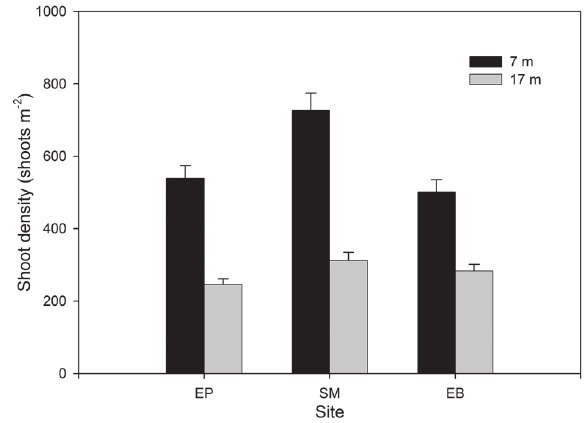
Fig . 1. – shoot density (shoots m -2 ) of Posidonia oceanica at three sites (eP: es Port; sM: cala santa María; eB: es Burri) and two depths (7 m, 17 m) in each site in cabrera archipelago national Park (Balearic islands, Western Mediterranean) in 2004-2006. error bars represent